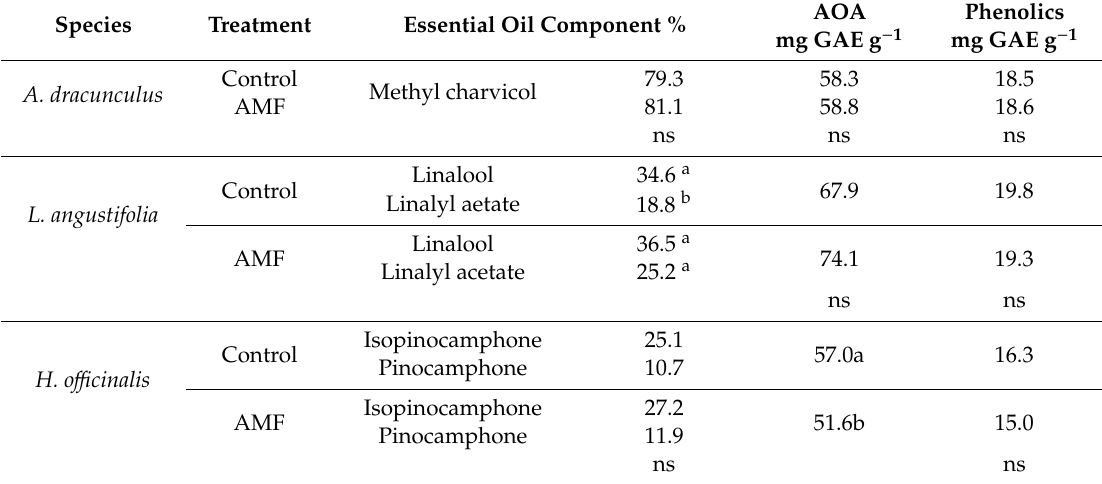
Table 2. Content of the main essential oil components, phenolics and antioxidant activity in aromatic plants, as a ff ected by AMF